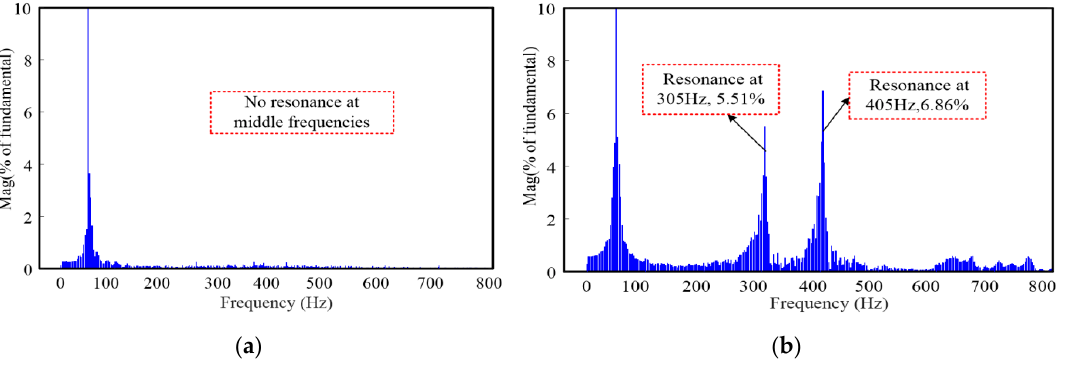
Figure 21. FFT analysis of stator voltage with Lead/Lag PLL (a) Low bandwidth; and, (b) High bandwidth.